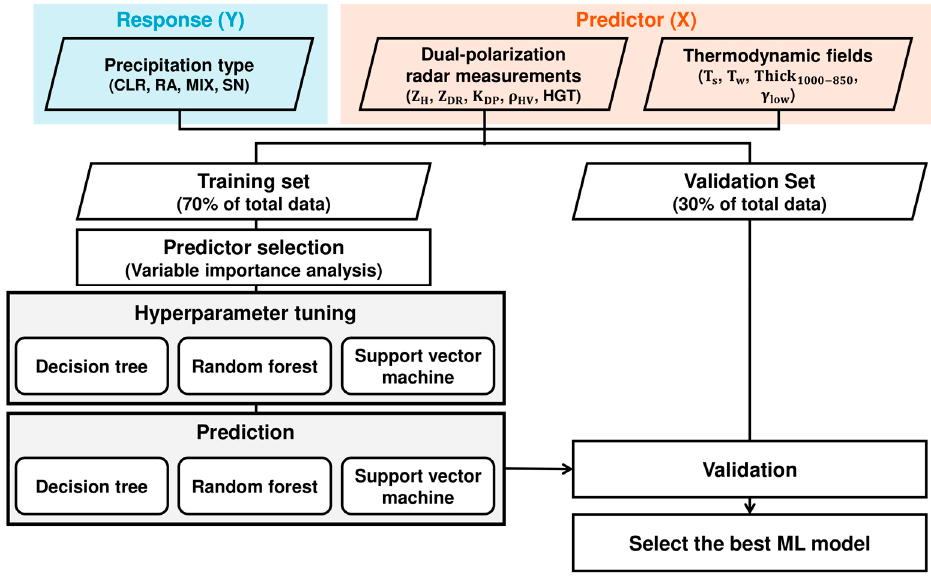
Figure 2. A flow chart for constructing the proposed machine learning